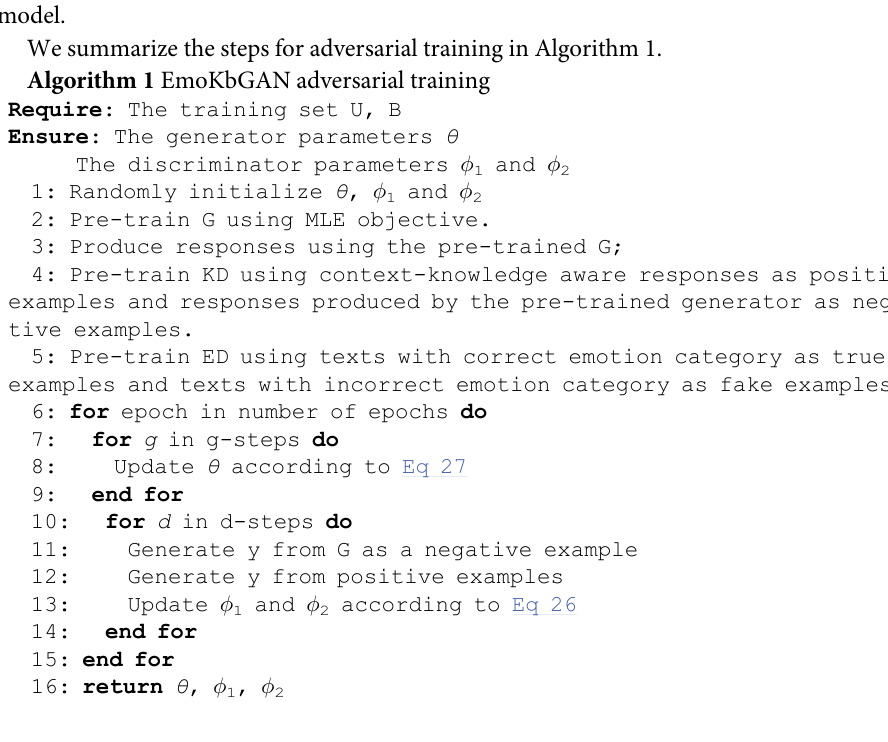
Algorithm 1 EmoKbGAN adversarial